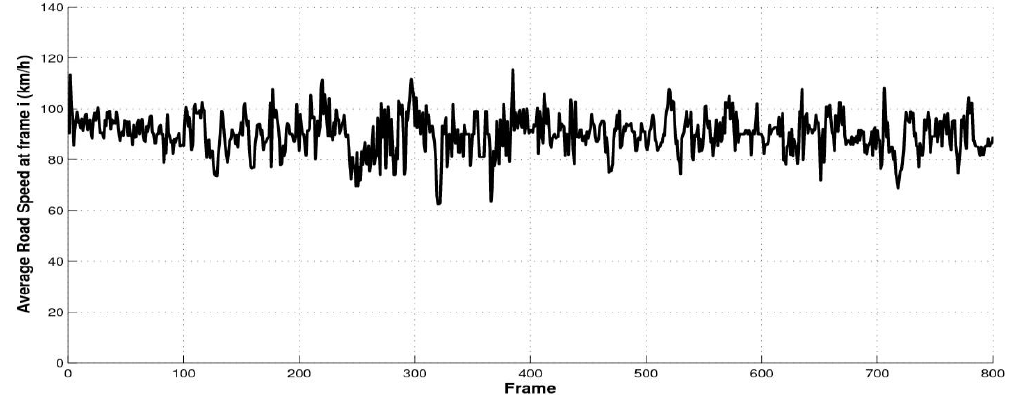
) using Equation i